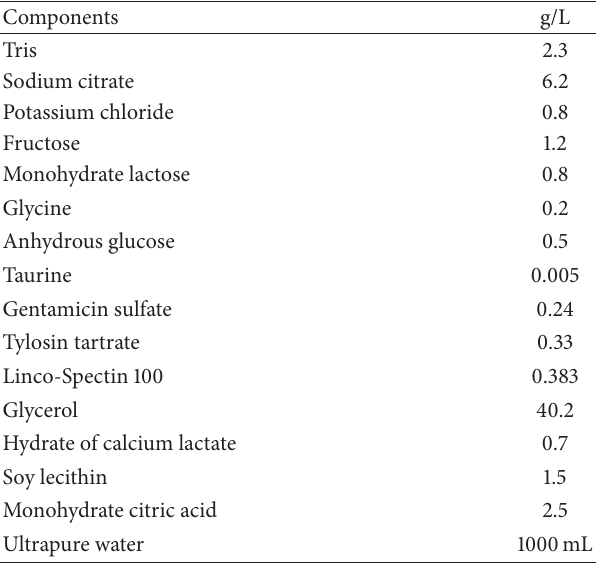
Table 2: Chemical composition of the diluent